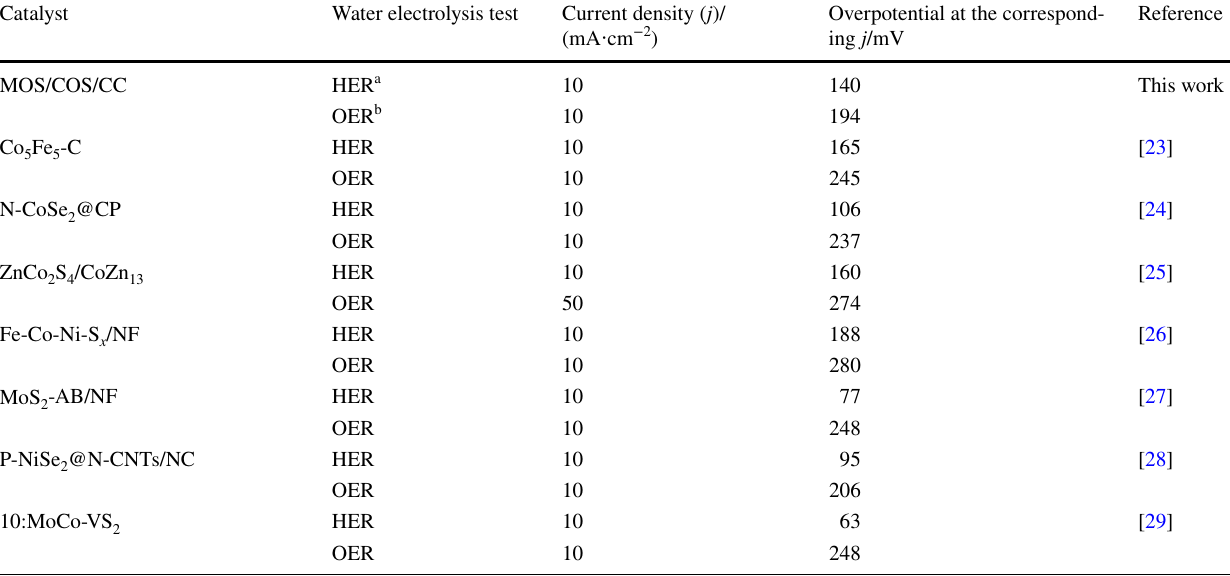
a HER stands for hydrogen evolution reaction b OER stands for oxygen evolution